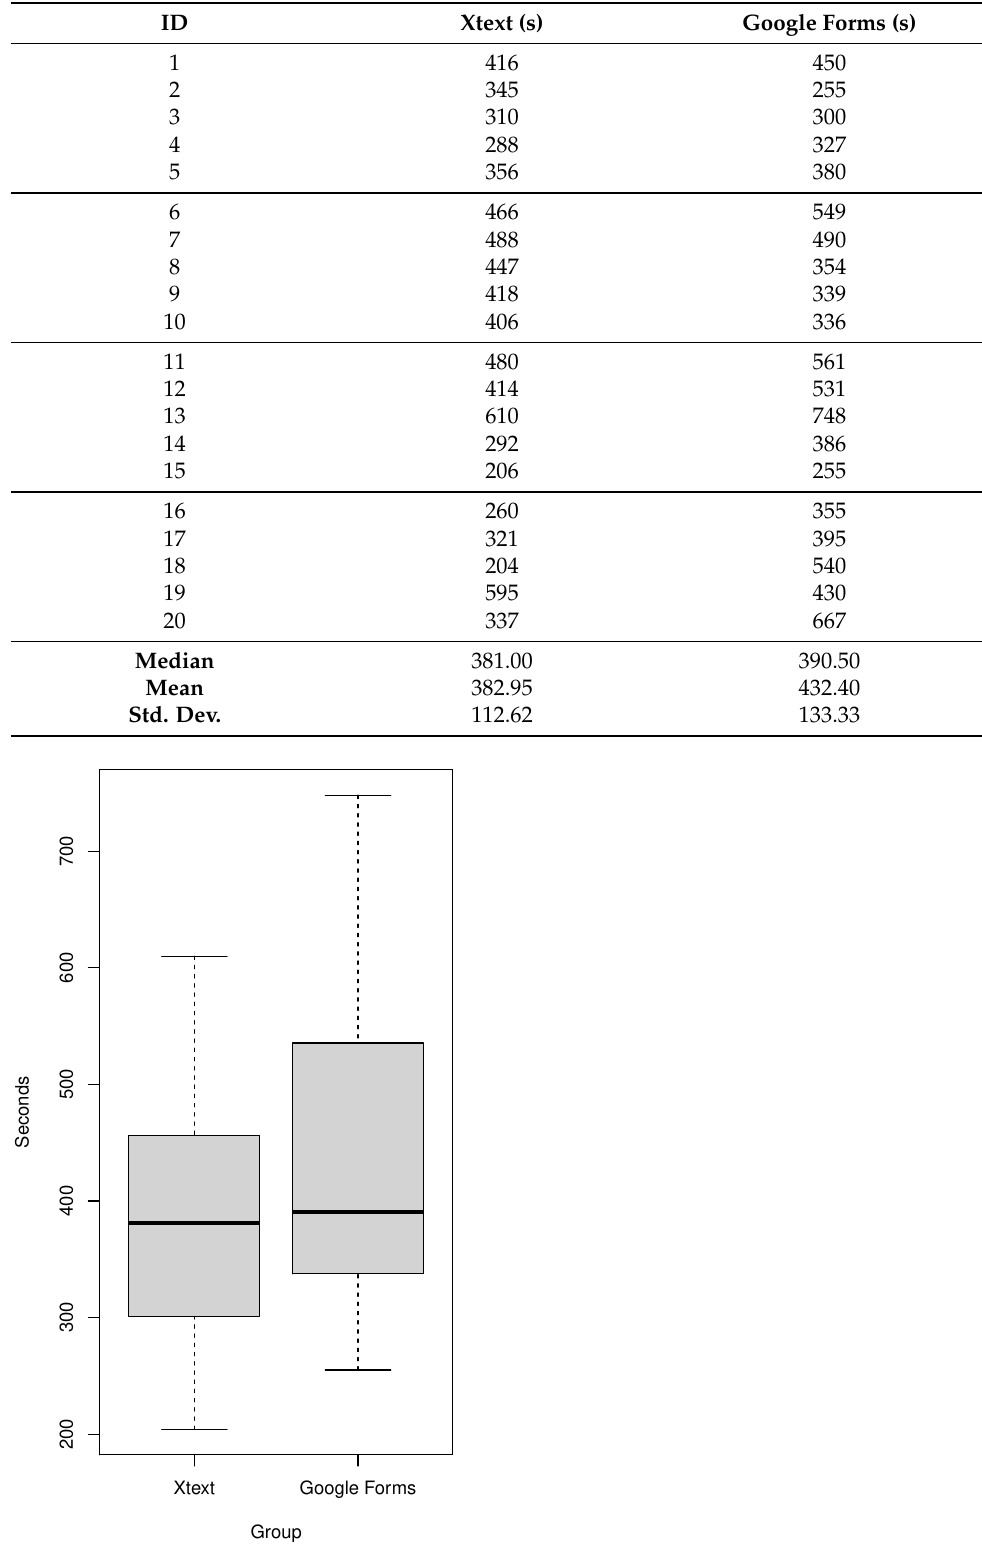
Figure 5. Results of the XText vs. Google Forms